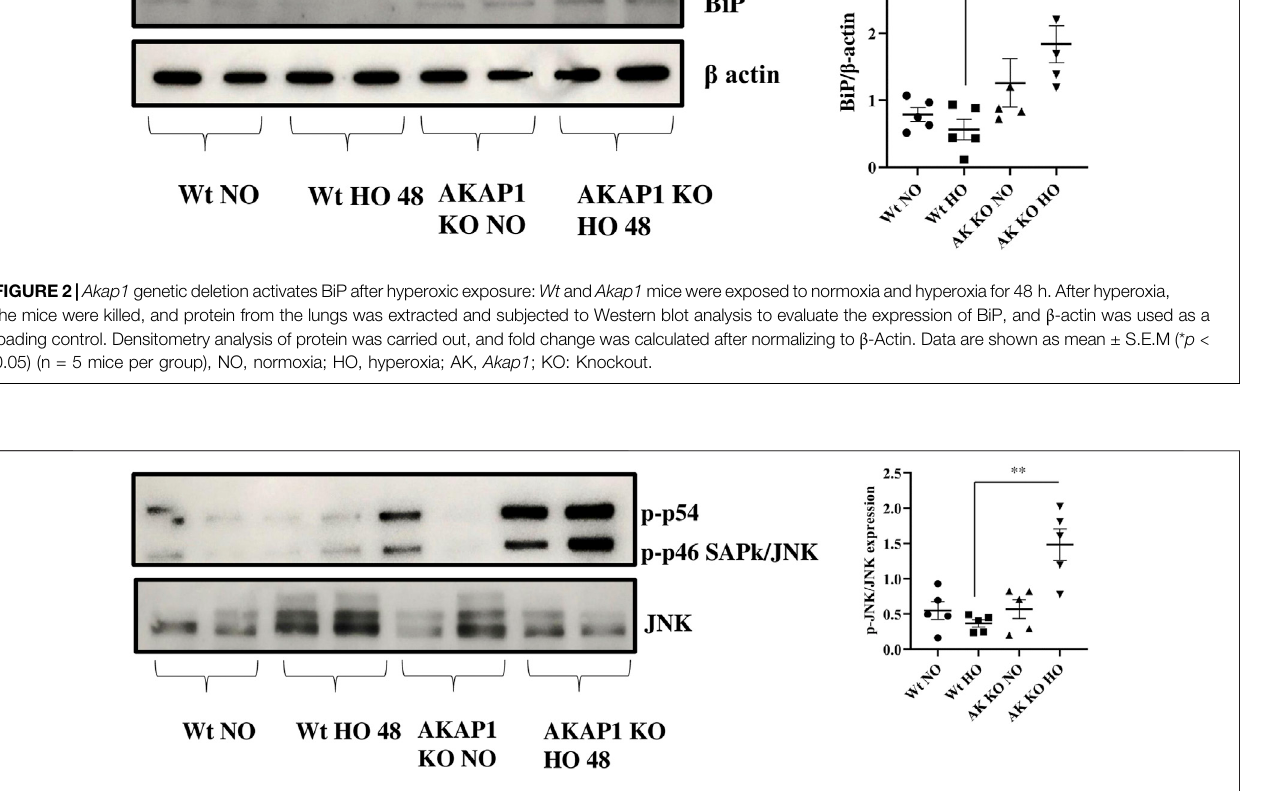
FIGURE3| Akap1 geneticdeletionactivatesJNKafterhyperoxicexposure: Wt and Akap1 micewereexposedtonormoxiaandhyperoxiafor48 h.Afterhyperoxia, the mice were killed, and protein from the lungs was extracted and subjected to Western blot analysis to evaluate the expression of JNK and p -JNK. Densitometry analysis was carried out, and after normalization with β -actin, the results were expressed in fold change. Data are shown as mean ± S.E.M (** p < 0.01) ( n = 5 mice per group), NO, normoxia; HO, hyperoxia; AK, Akap1 ; KO: Knockout.